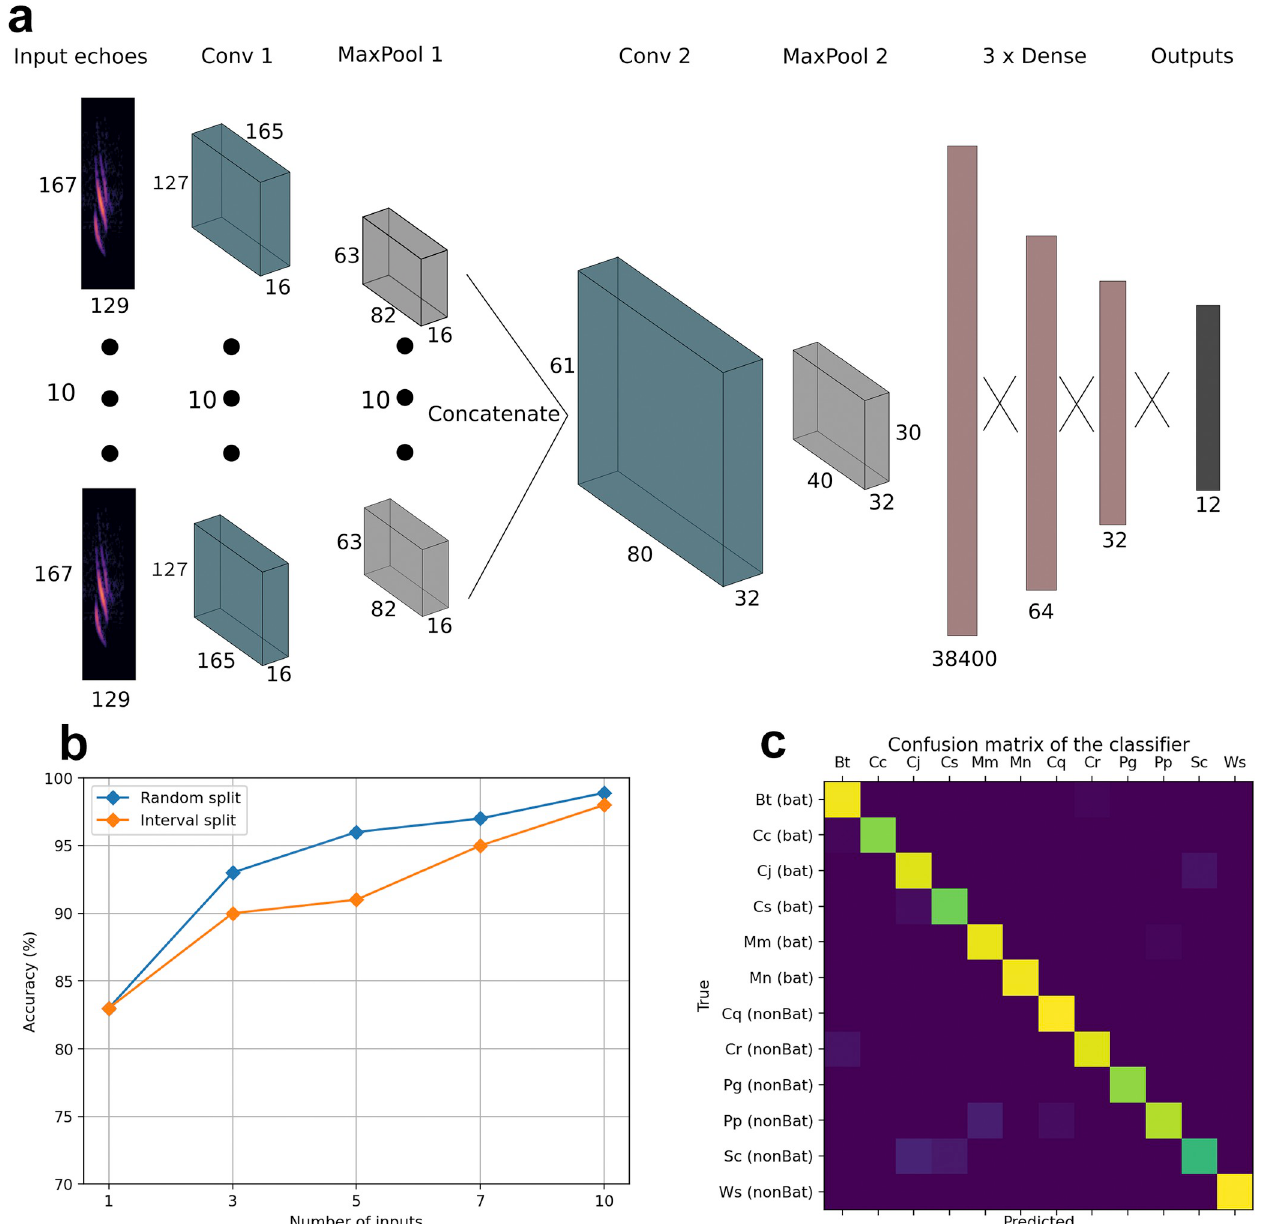
Fig 4. Echo classification using convolutional neural networks. ( a ) Architecture of the neural network. ( b ) Results of the CNN model on two different iterations of the data and different amounts of echoes as the input. ( c ) The confusion matrix of a trained 10-input CNN on the testing set.